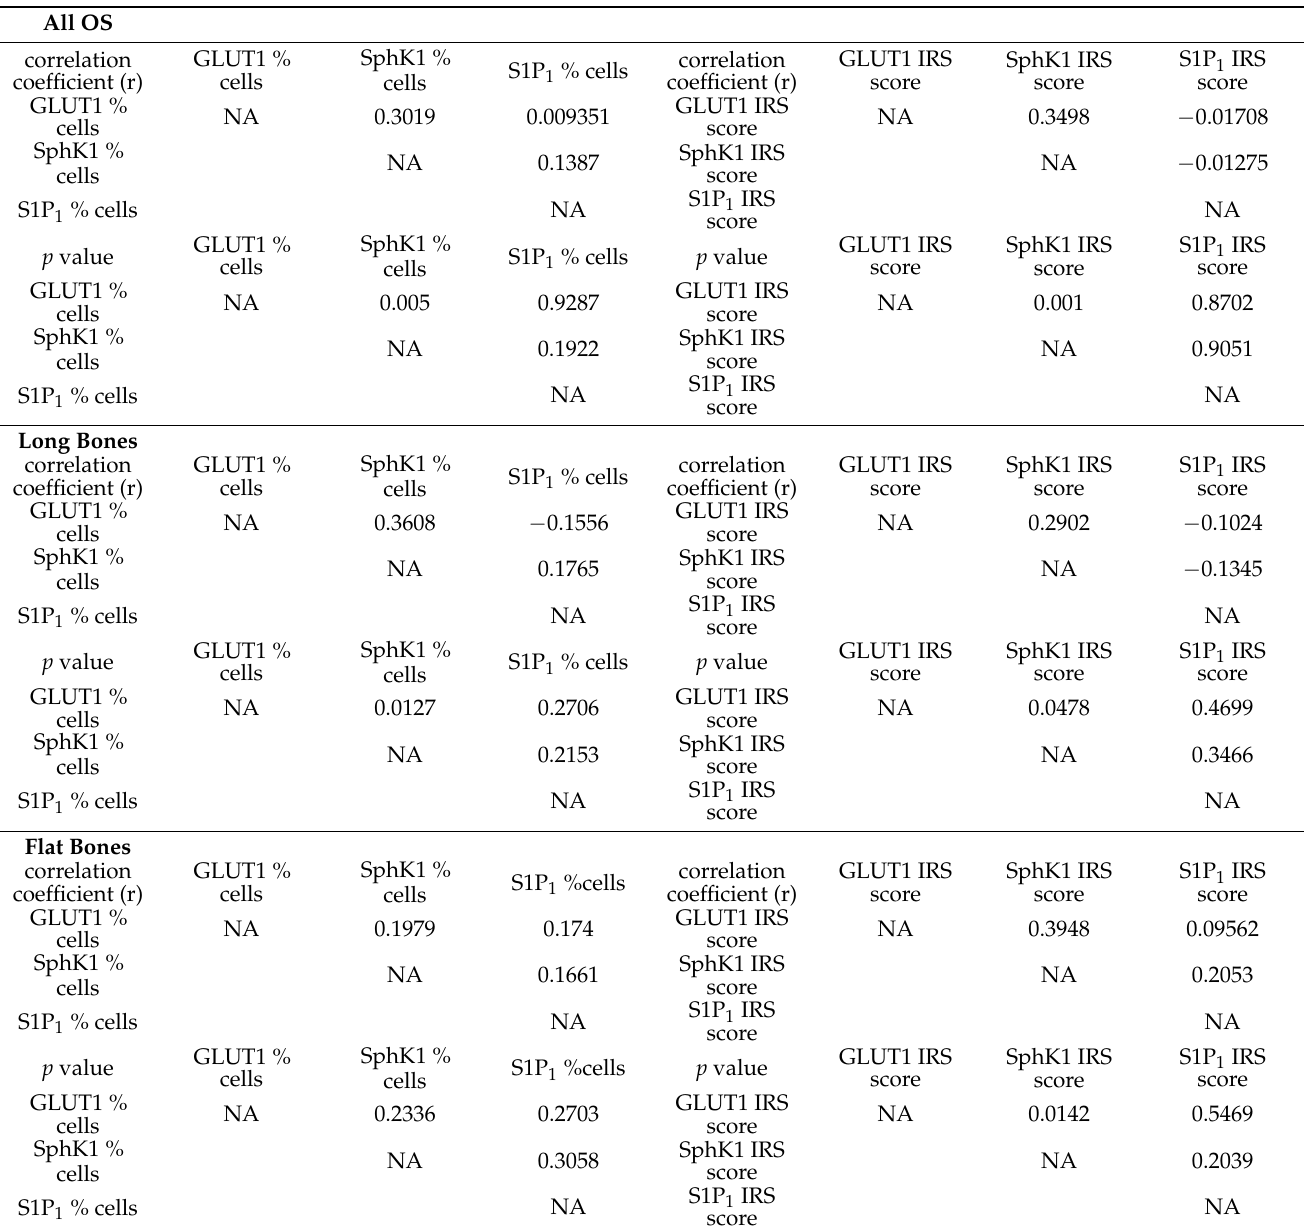
Table 4. Correlation between GLUT-1, SphK1 and S1P 1